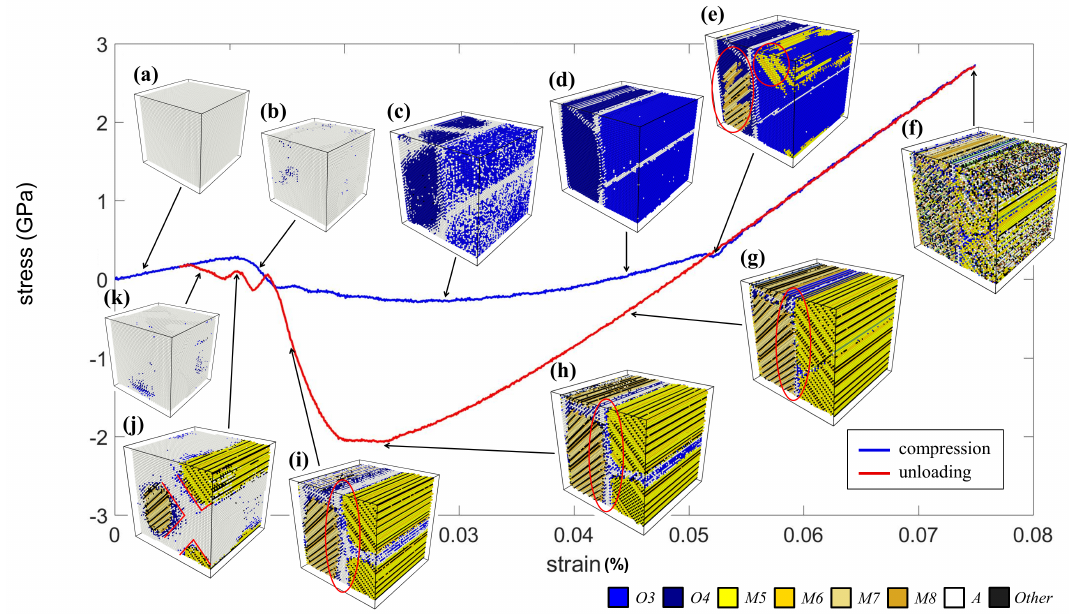
Figure 4. The stress–strain curve of the NiTi shape memory alloy (SMA) subjected to the compression process. The corresponding microstructures at stages ( a – k ) are